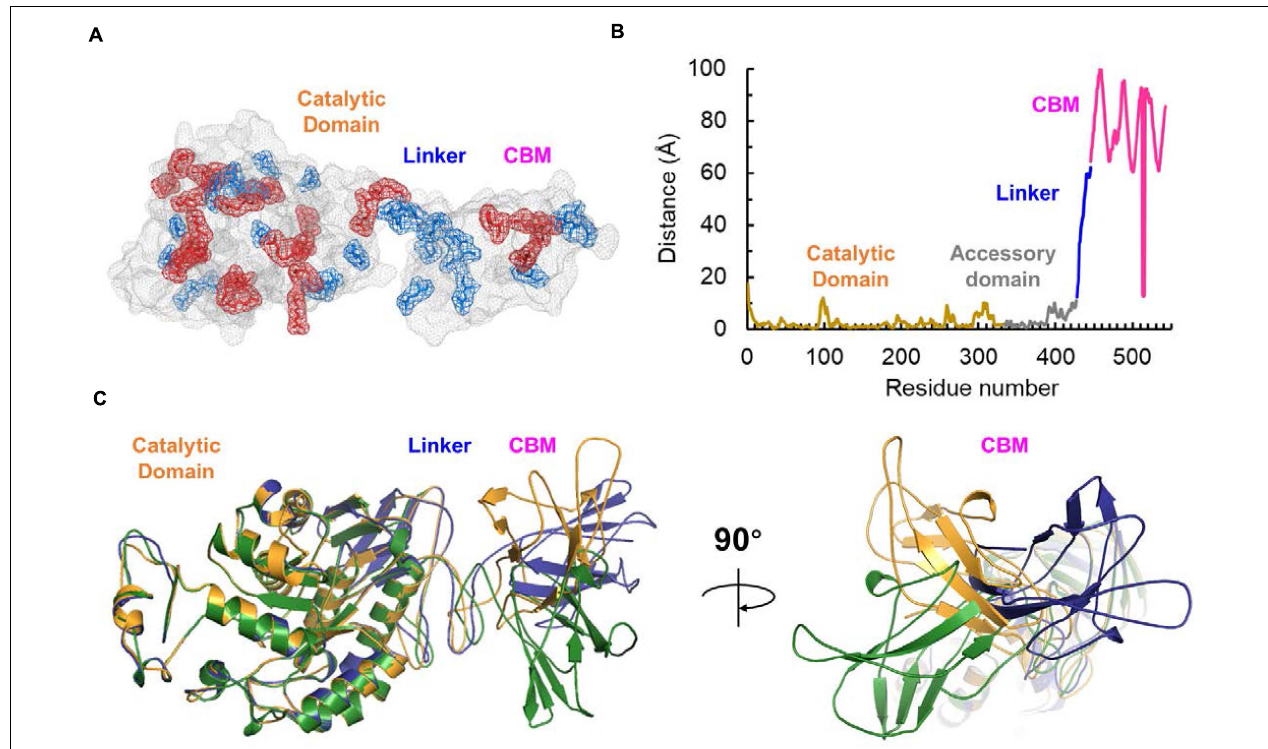
FIGURE 5 | Surface electrostatic potential and flexibility analysis of SdG5A. (A) Distribution of charged residues on the SdG5A surface. Acidic residues including glutamic acid and aspartic acid are indicated in blue; basic residues including histidine, lysine, and arginine are indicated in red. (B) Residue-specific distance to the equilibrium native state. The distance was estimated by ResQ server based on the support vector regressions. (C) Distance-based predicted structural model of SdG5A. All structures were predicted using the RaptorX web server and rendered using the PyMOL Version 2.2.3 software.